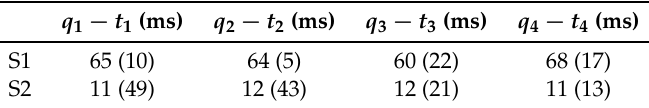
Table 2. Mean (std. dev.) of time difference between feature points extracted from real-time MRI data in the mid-sagittal plane ( t 1 − t 4 ) and from the corresponding sound ( q 1 − q 4 ). Time resolution of the MRI is 19.8 ms.